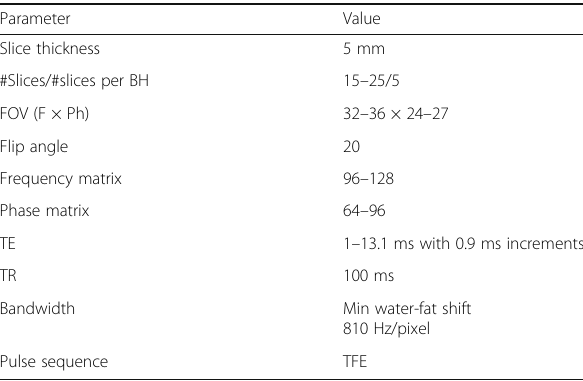
Table 3 Parameters for axial T2* imaging